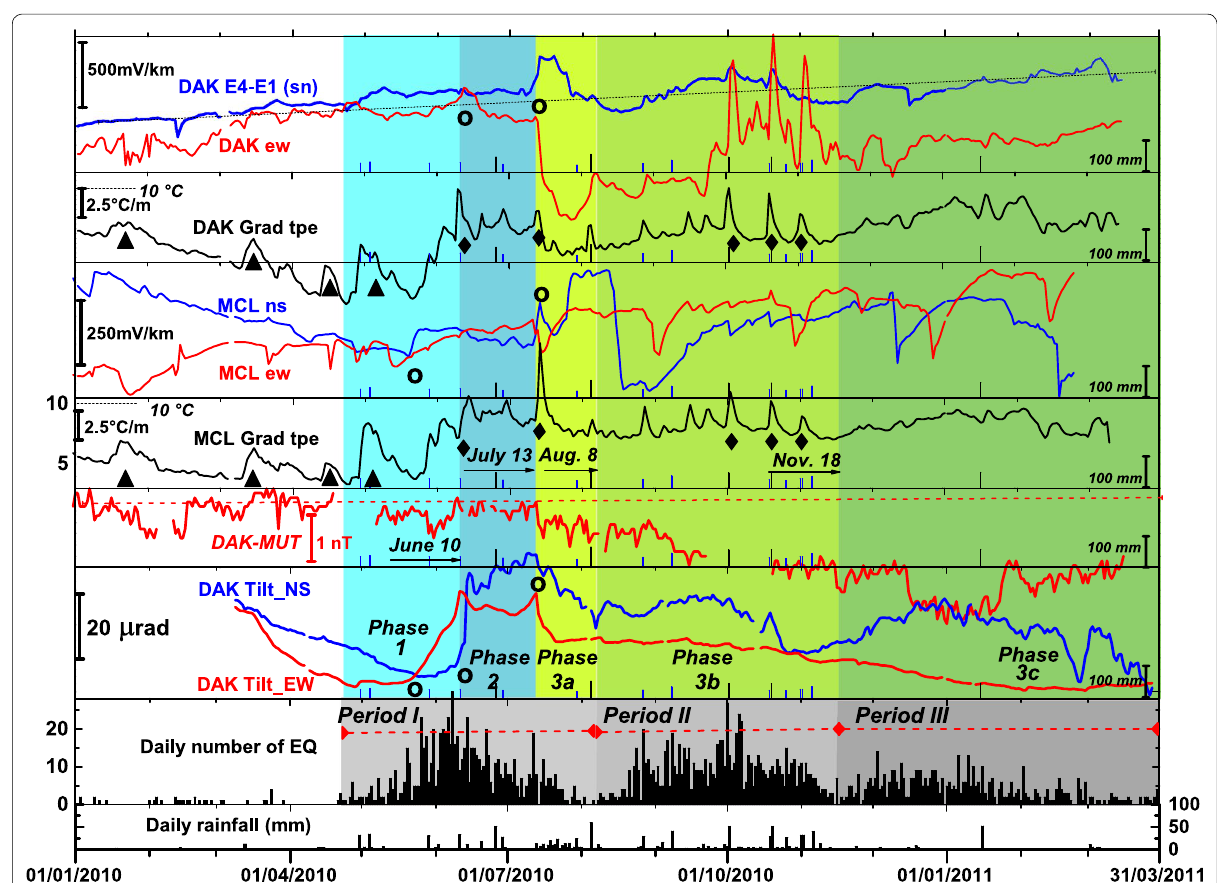
Fig. 6 Multi-parametric data recorded during the 2010 seismovolcanic crisis between January 1, 2010, and March 31, 2011. Gray boxes correspond to periods of seismic activity. Colored boxes match the different phases of tilt variations during the crisis (see text for detail). From top to bottom— Horizontal components of the electric field at DAK station (S–N, E–W), Thermal gradient at DAK, Horizontal components of the electric field at MCL station (N–S, E–W), thermal gradient at MCL, total magnetic difference [ DAK – MUT ], NS and EW components of the self-leveling borehole tiltmeter at DAK, daily number of earthquakes (PHIVOLCS document) and daily rainfall (in mm/day) at the local Buco Observatory. Black triangles represent bay-type thermal anomalies, black diamonds correspond to sharp transient thermal anomalies, and black circles figure the onset of larger common electric field and tilt signals (see text for detail). Rainfall above 25 mm (blue line) and above 50 mm (dark line) is added to each plot for